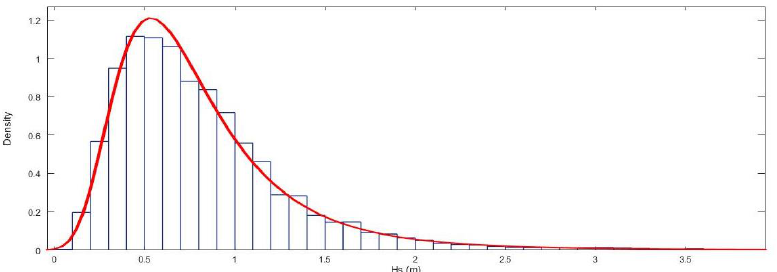
Figure 8. Frequency histogram of the significant heights, calculated on every node and during the TMY. Red line represents the Generalized Extreme Values probability density function used to describe the values distribution.